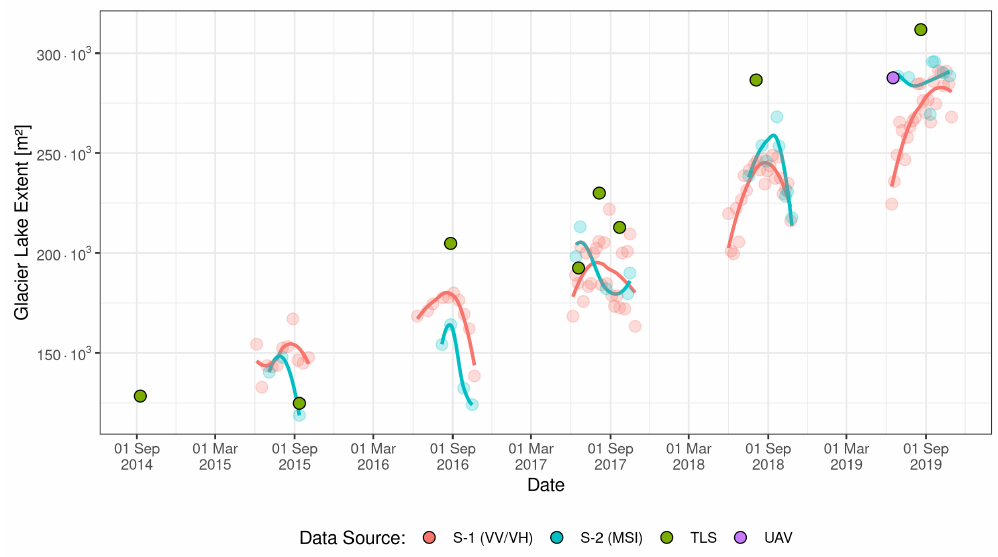
Figure 3. Evolution of the extent of Lake Pasterzensee from 2014-09-01 to 2019-10-01. Abbreviations of data sources: S-1 (VV/VH), Sentinel-1 polarization VV/VH (vertically transmitted and vertically or horizontally received radiation (spatial resolution = 5 × 20 m); S-2 (MSI), Sentinel-2 multispectral instrument (spatial resolution = 10 m); TLS, Terrestrial Laserscanning (spatial resolution = 1